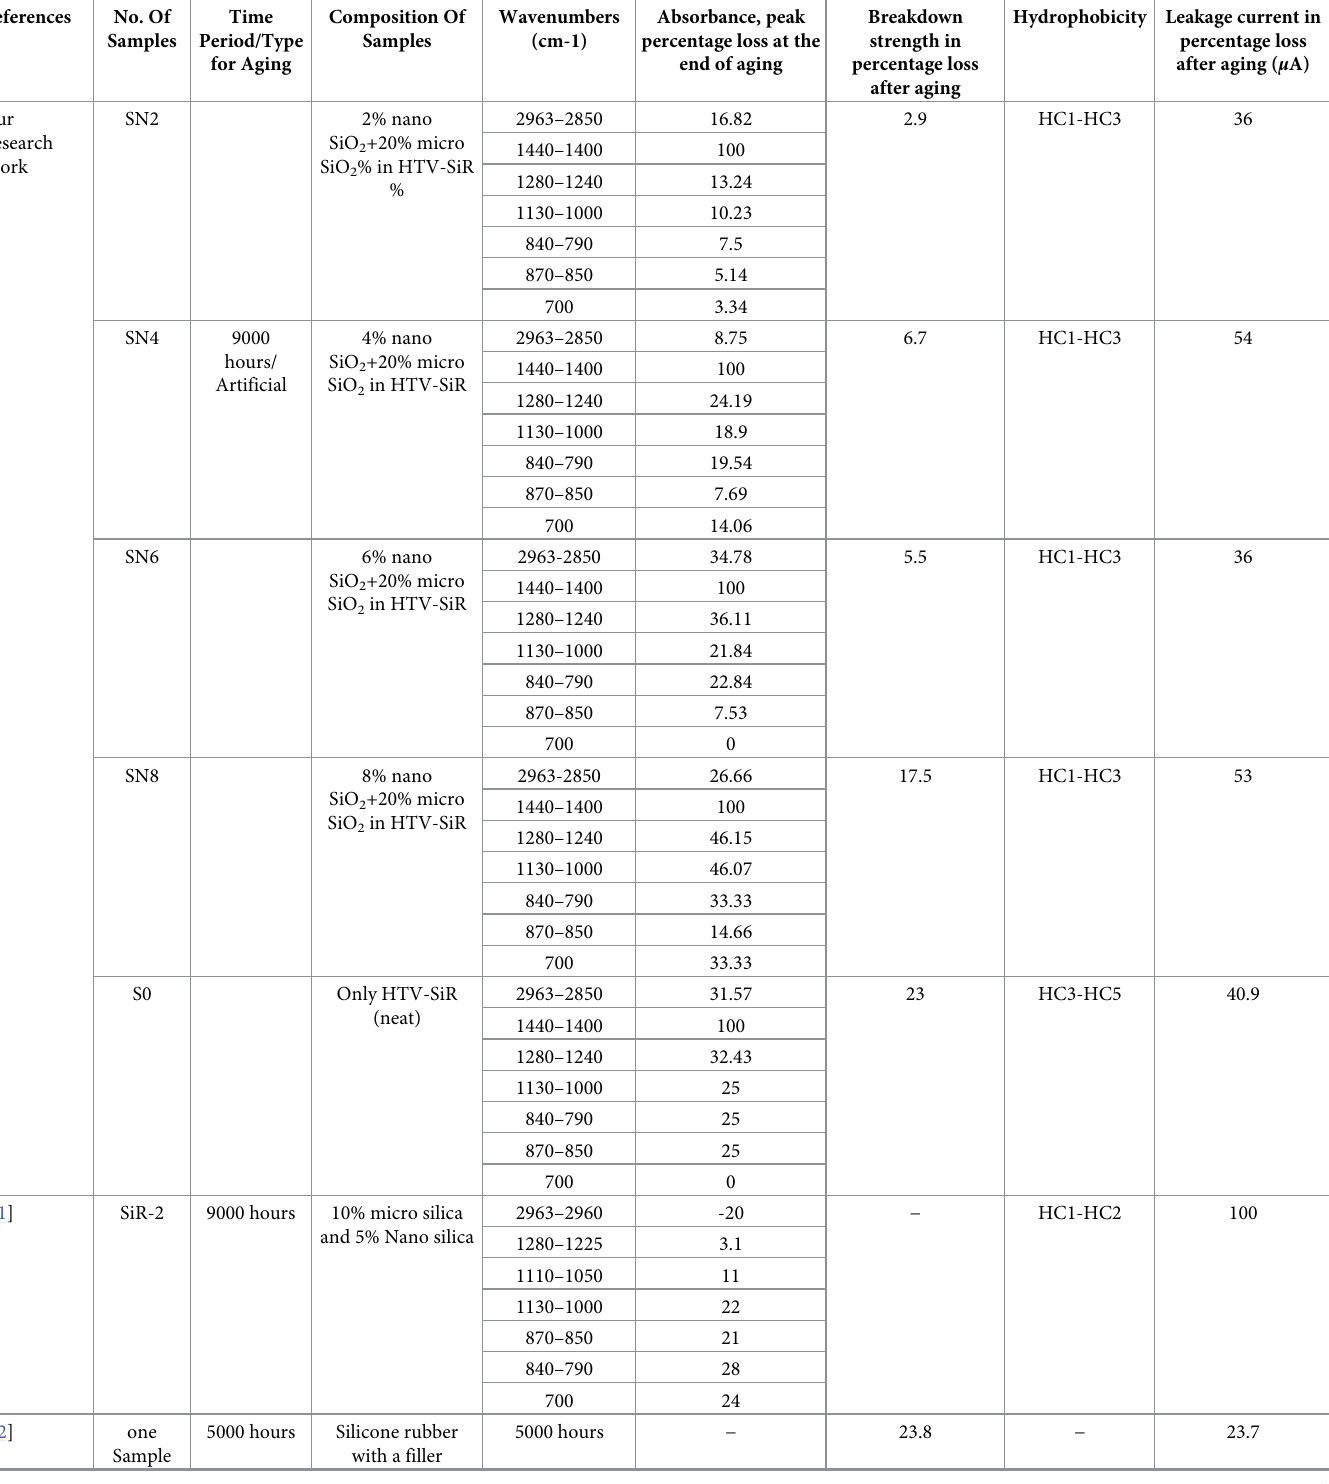
Table 4. Comparison with state-of-art work, here 0 - 0 indicates the